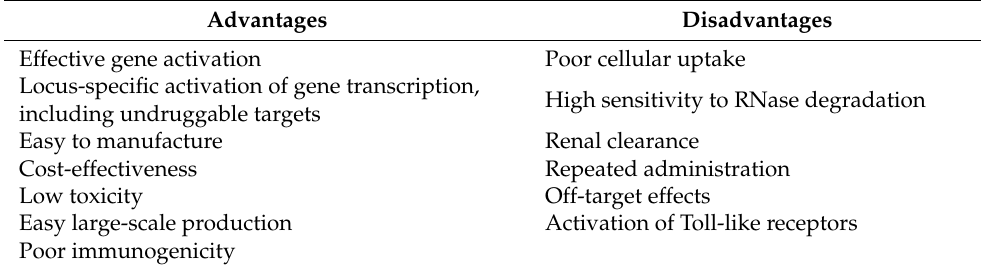
Table 1. Pros and cons of using saRNAs as therapeutics. Advantages